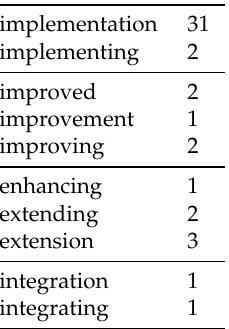
Table 5. Occurrence of keywords in titles of WNS3 papers.